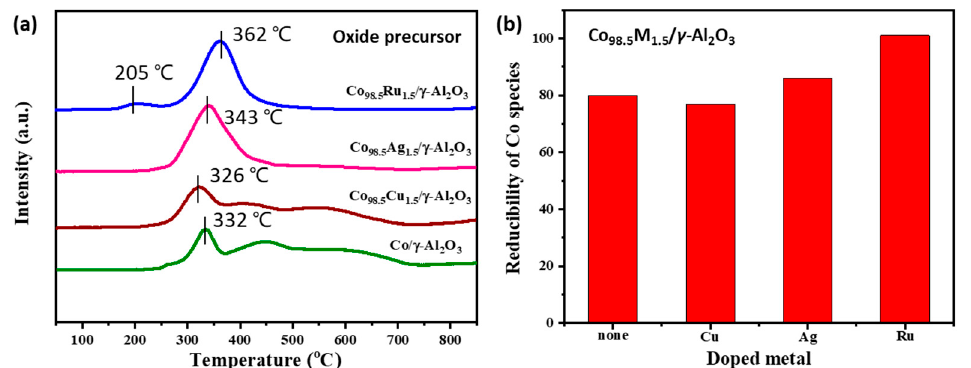
Figure 4. ( a ) H 2 temperature-programmed reduction profiles for the oxide precursors of Co 98.5 M 1.5 / γ -Al 2 O 3 (M = Cu, Ag, Ru; 5 wt% Co) samples (i.e., Co 98.5 M 1.5 O x / γ -Al 2 O 3 ) and ( b ) the effects of the doped metal on the reduction degree of the Co specie in these reduction processes.